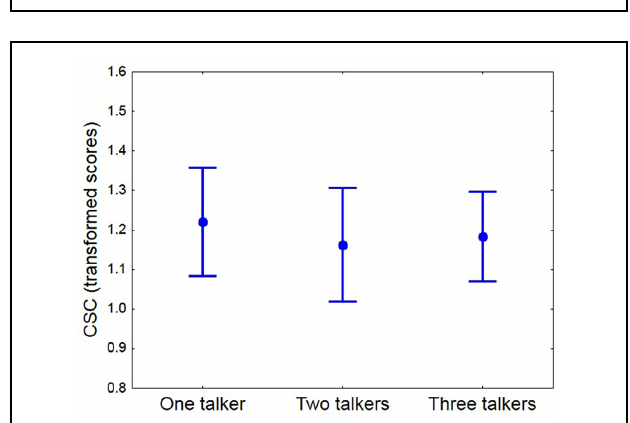
FIGURE 4 | The mean transformed CSC score for each simulated talker condition (maximum = 1.57). Whiskers show 95% confidence